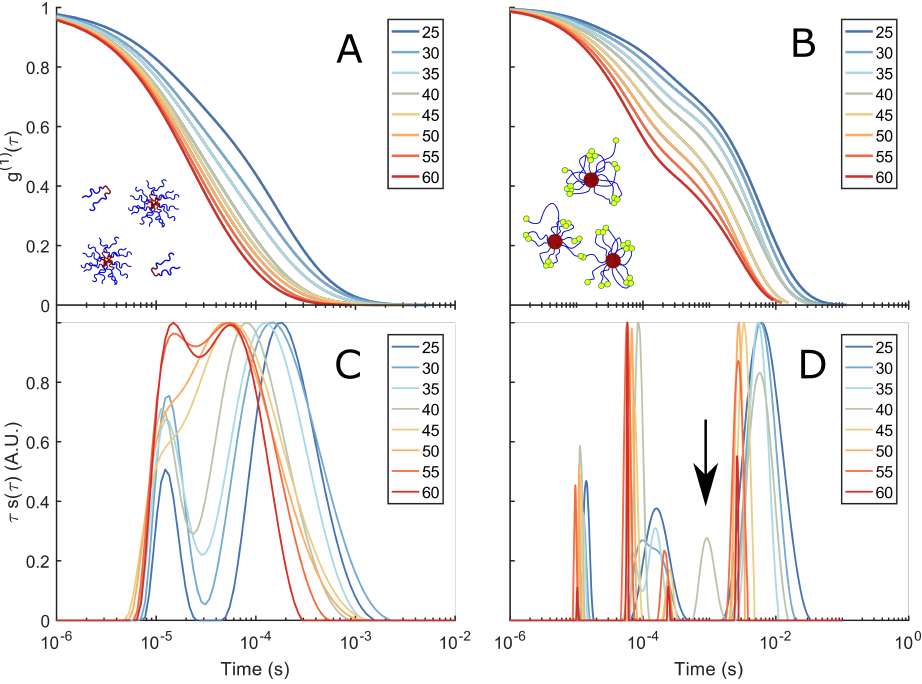
Figure 3. DLS spectra and corresponding relaxation times: ( A ) g ( 1 ) ( τ ) of a 10% w/v F108 solution in 100mM NaCl measured in DLS as function of temperature. ( C ) Corresponding relaxation–time distributions s ( τ ) , obtained by constrained regularisation fitting of the experimental g ( 1 ) ( τ ) using an in-house routine [37]. The vertical axis τ s ( τ ) provides an equal area representation. The curves have been normalised to the highest peak of s ( τ ) to facilitate the comparison between different tempera- tures. ( B ) g ( 1 ) ( τ ) of a 10%w/v F108-N 3 - AA (cid:48) solution in 100mM NaCl and ( D ) the corresponding distributions of relaxation times. The arrow indicates the small peak at τ ∼ 10 − 3 s for T = 40 °C. To this end we performed DLS studies on F108-N 3 samples without the DNA attach- ment. In Figure 4, we compare 8.25 % w/v samples of F108-N 3 with the pure F108 and F108-N 3 -DNA (10:1) carrying only A -DNA, not allowing for binding between PEO-chain ends. The electric field autocorrelation functions show a clear difference between the non-functionalised F108 and the one with azide and azide-DNA. In general, we observed that the g ( 1 ) ( τ ) curves for F108 decay faster as the temperature increases, with no distinctly long relaxation time τ 3 . However, both F108-N 3 and F108-N 3 - A samples display similar τ